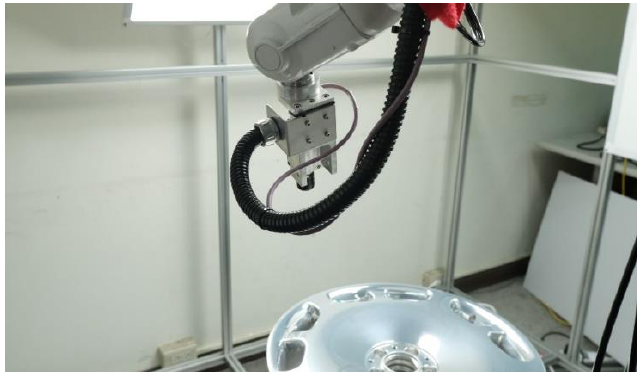
Figure 14. Practical implementation of the proposed defect detection system.